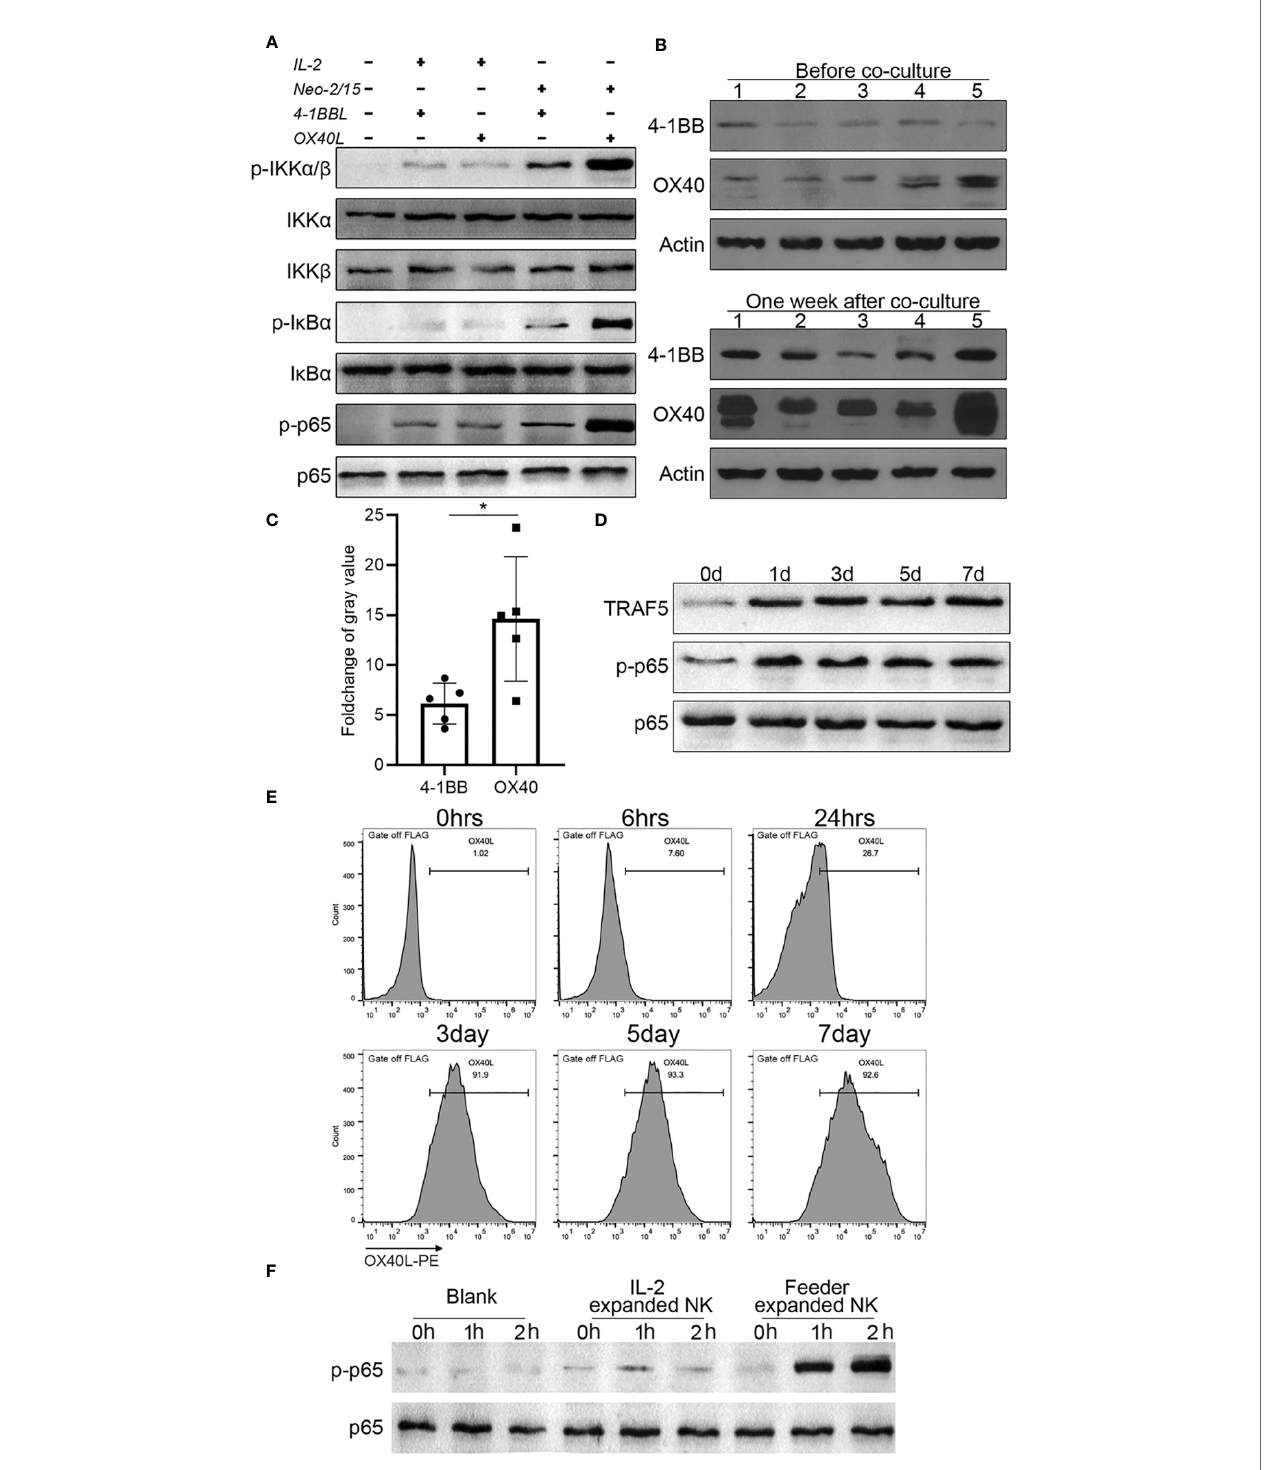
FIGURE 4 | NK92-Neo2/15-OX40L promotes an OX40-OX40L positive feedback loop (*p < 0.05). (A) Western-blot detection of NK- k B activation for indicated treatment. (B) 4-1BB and OX40 expression in expanded NK cells from 5 donors, measured by Western-blot before and after feeder cell treatment. (C) Relative gray value statistics of protein level in (B) . (D) Immunoblot of TRAF5, phosphorylated-p65, and p65 was detected. (E) FACS analysis of OX40L expression on expanded NK. (F) NK cells from PBMC, treated by IL-2 or NK92-Neo2/15-OX40L expanded NK cells at a ratio of 19:1, freshly collected NK cells were used as control. Phosphorylated p65 were determined by western